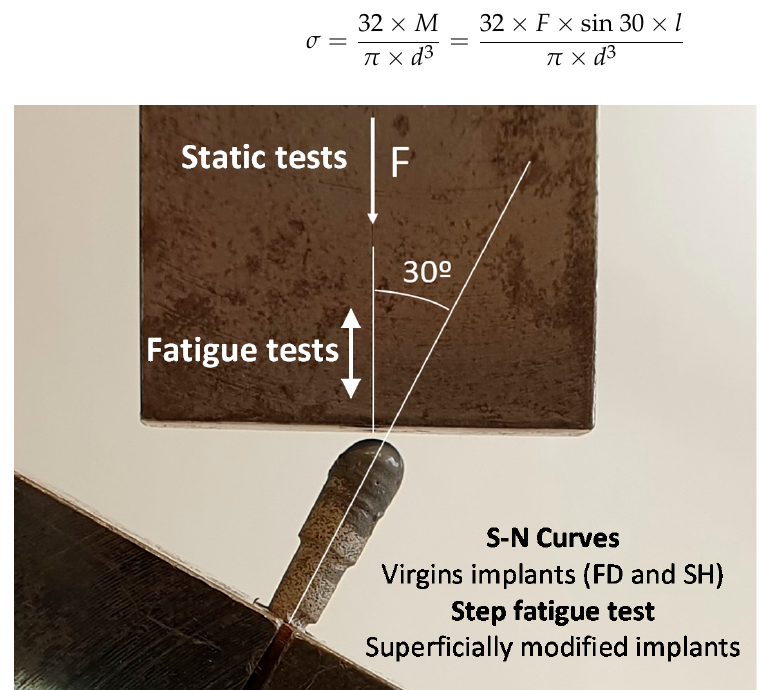
Figure 2. Setup and parameters of the static and fatigue test of the porous dental implants, following the standard ISO 14801.